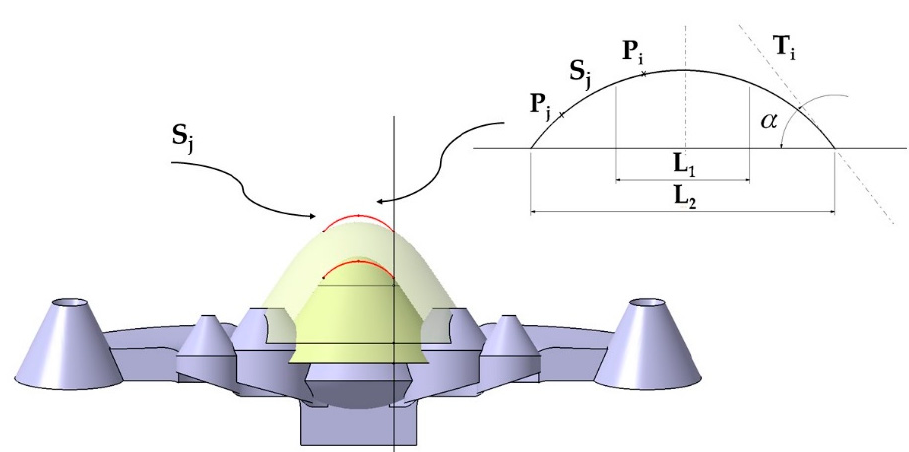
Figure 6. Generating curve S j.